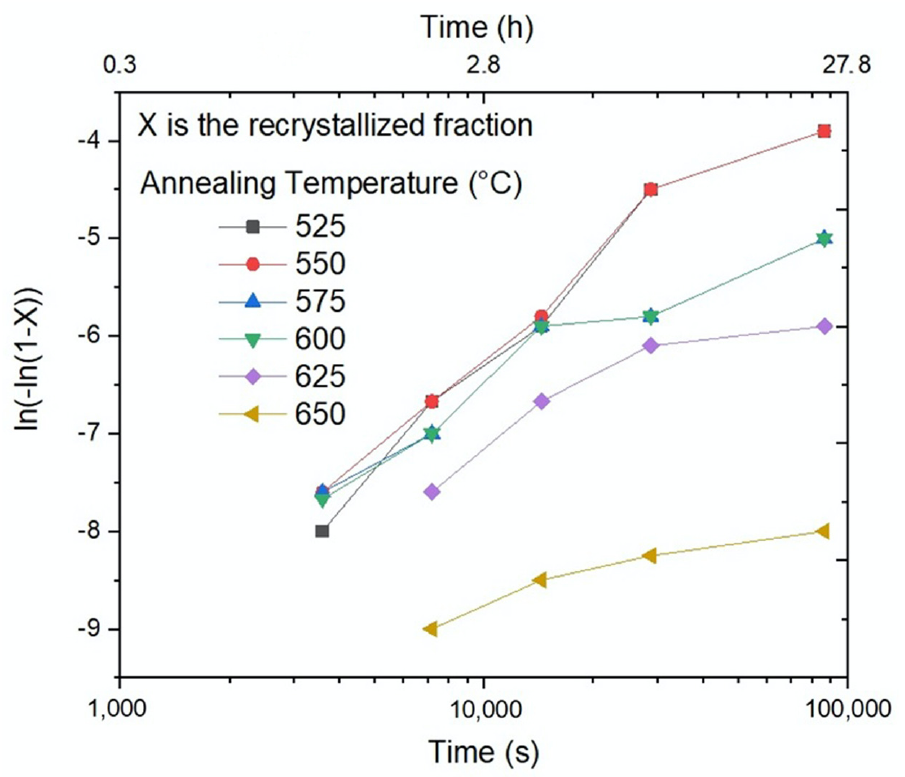
Figure 9. Linearization of the (Mn,Fe) 3 C volumetric fraction according to the kinematic JMAK model Equations (1) and (2). 80% cold-deformation. Table 2. JMAK parameters for Fe-Mn carbide.